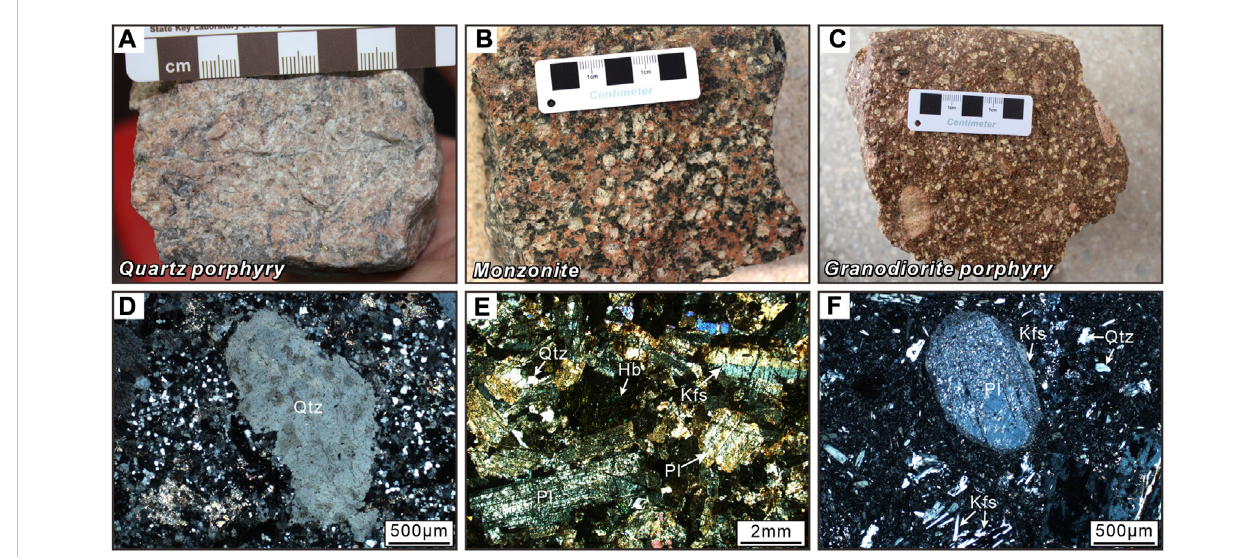
FIGURE 3 Photographs and photomicrographs showing the main texture and mineral assemblages of three major intrusions of the Kalmakyr deposit. (A) Quartzporphyry; (B) Monzonite; (C) Granodioriteporphyry; (D) Anhedral quartzphenocrystsofquartz porphyryundercross-polarizedlight; (E) Euhedral tosubhedral,plagioclase,andK-feldspar,andminorbiotite,hornblende,andquartzphenocrystsinmonzoniteundercross-polarizedlight; (F) Plagioclase phenocryst partially rimmed by K-feldspar in granodiorite porphyry under cross-polarized light. Mineral abbreviations: Qtz, quartz; Pl, plagioclase; Kfs, K-feldspar; Hb, hornblende; Bio,